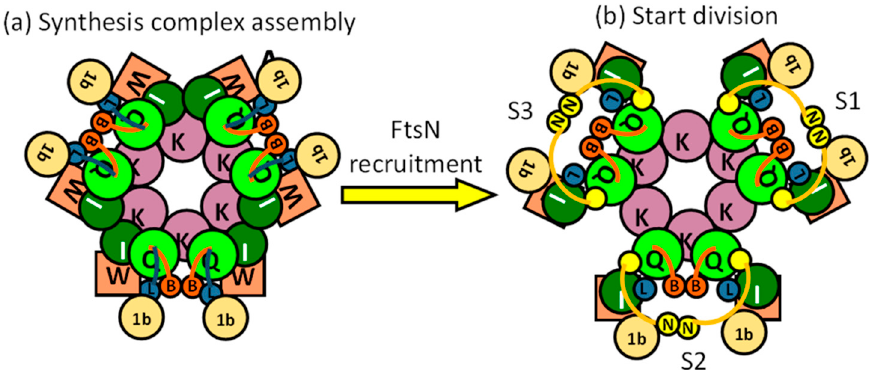
Figure 17. Stoichiometry of the synthesis complex. ( a ) A synthesis complex, shown from above in the periplasm, is assembled around FtsK hexamers, consisting of three synthesis nodes. Each synthesis node is comprised of 2 FtsBLQ–FtsWI–PBP1b subcomplexes, which assemble around FtsK through FtsQ. ( b ) FtsN recruitment activates the synthesis complex, leading to sPG synthesis by the three synthesis nodes (S1, S2 and S3).